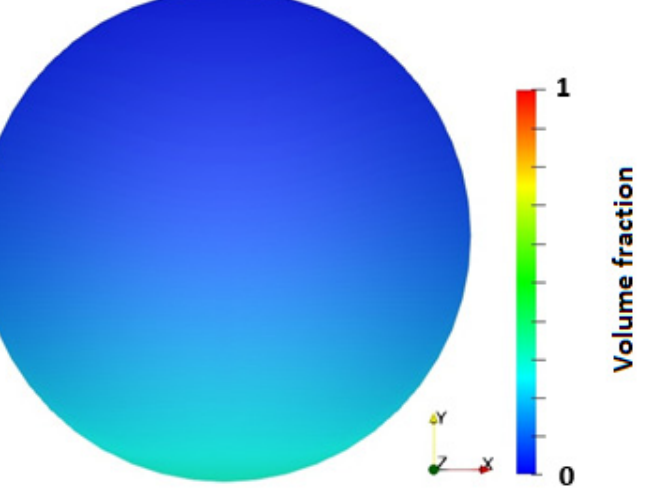
Figure 11. Distribution of water volume fraction across pipe section for test 3 (mixture velocity = 2 m/s, water cut = 0.1).